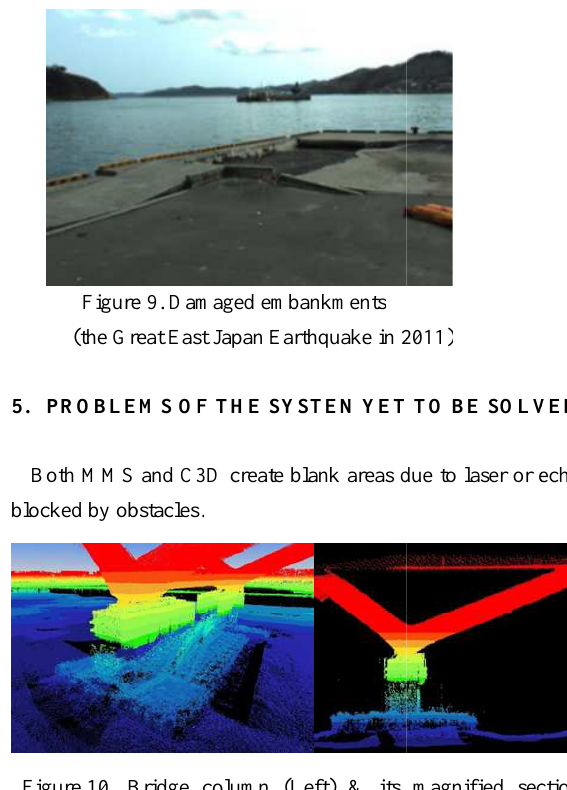
Figure.10. Bridge column (Left) & its magnified section (Right)